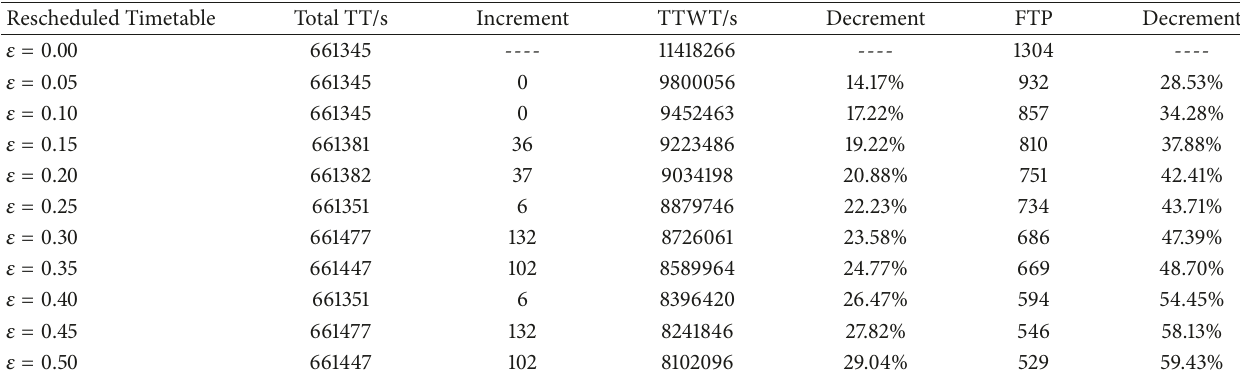
Table 5: A comparison between total TT, TTWT, and the number of